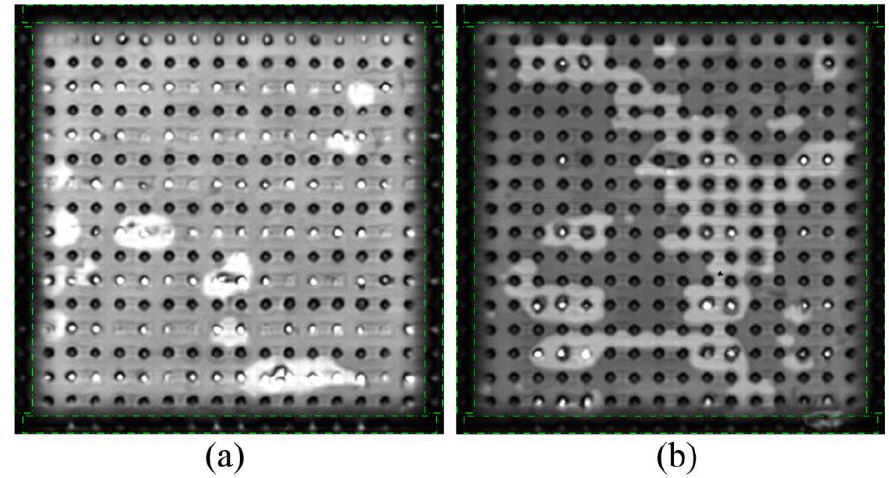
Figure 5. ( a and b ) SAM images of the flip chips I and II; ( c ) The typical time-domain signals of good and missing solder